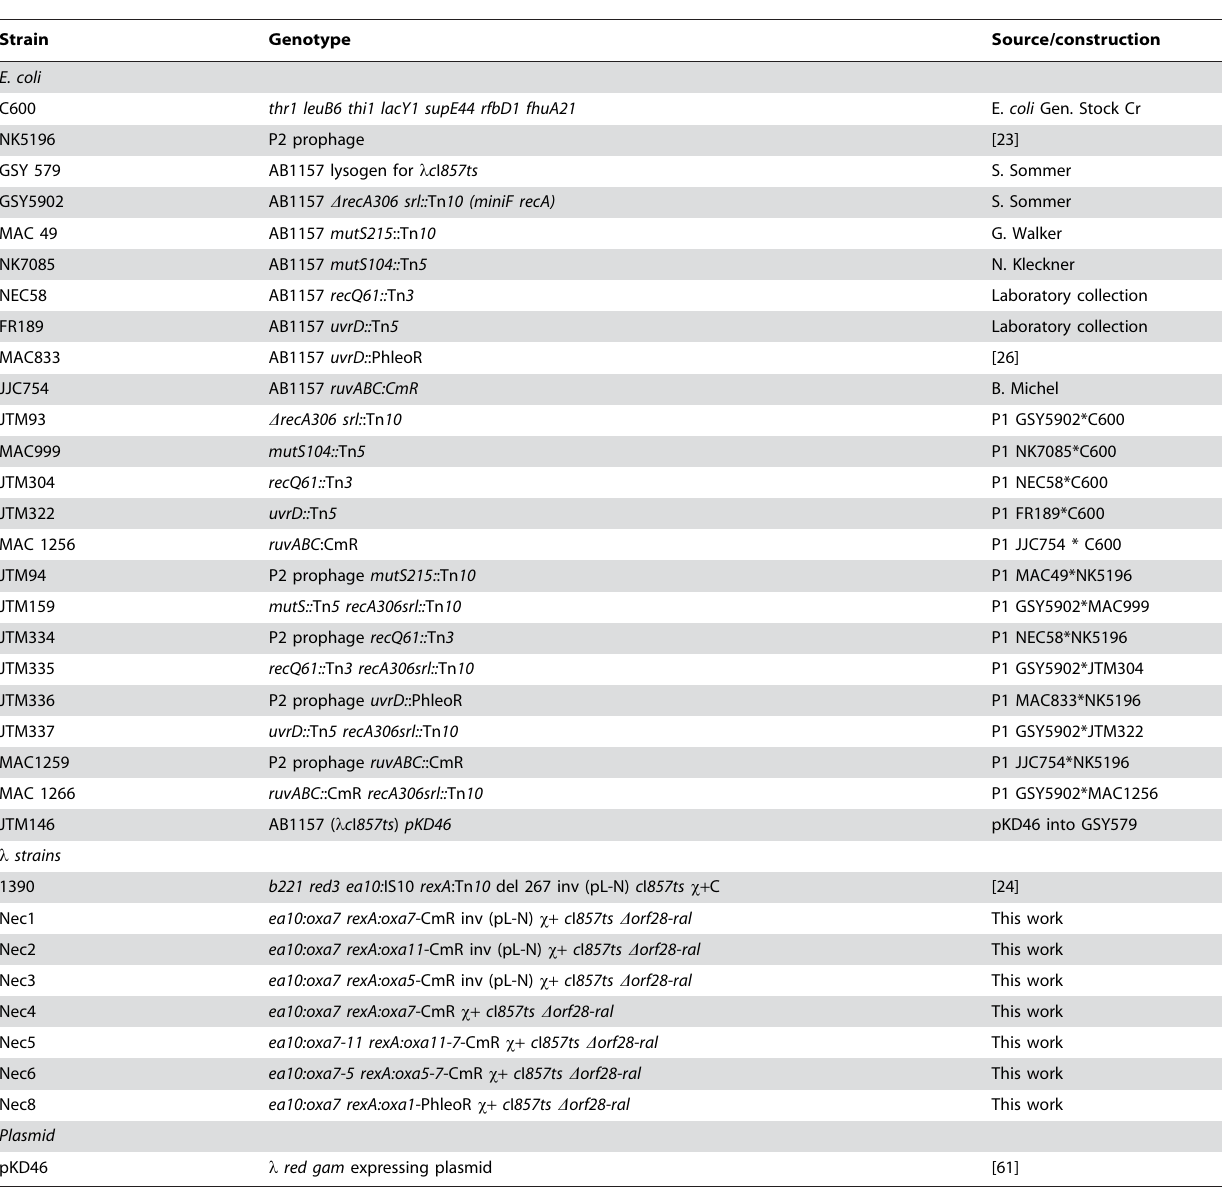
Table 4. Strains and plasmids used in this study (All E. coli strains, unless specified otherwise, are derivatives of